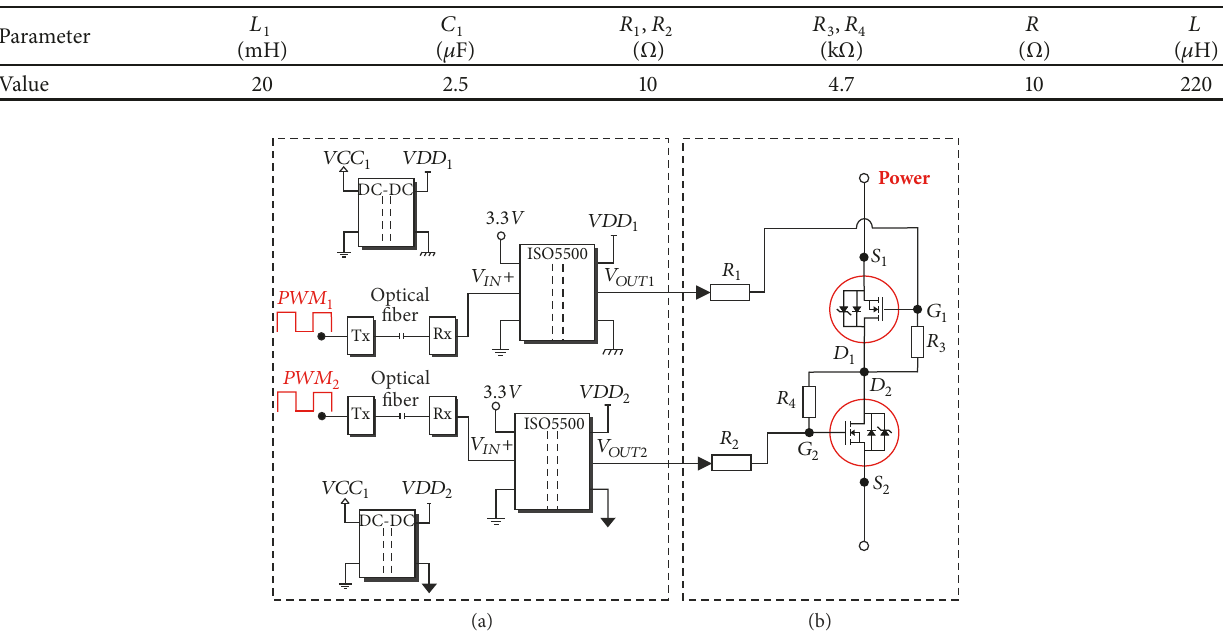
Figure 3: Electric diagram of Bi-Sw, (a) buffer circuit and (b) power module circuit.